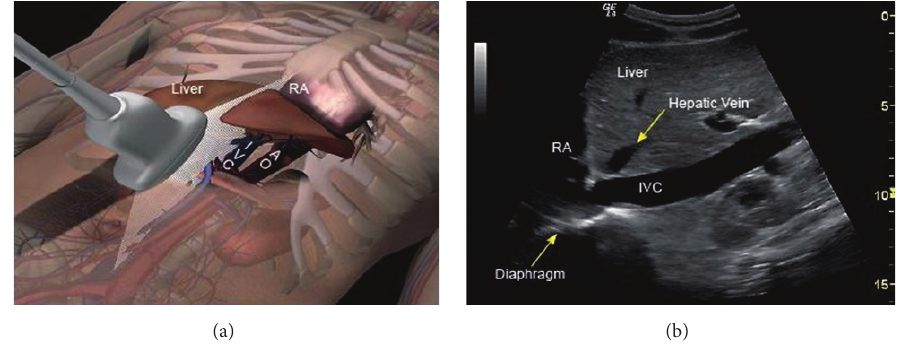
Figure 3: Subcostal inferior vena cava landmarks. (a) Position of ultrasound probe for visualization of the inferior vena cava (IVC) (see Figure 1, probe position B1). The IVC is located to the right of midline and aorta (AO). (b) Corresponding ultrasound image of the IVC. The IVC is typically measured 2 cm from the right atrium (RA) or just distal to the hepatic vein. The hepatic vein junction to IVC and the IVC junction to right atrium are confirmatory landmarks. Reproduced with permission from Killu et al.